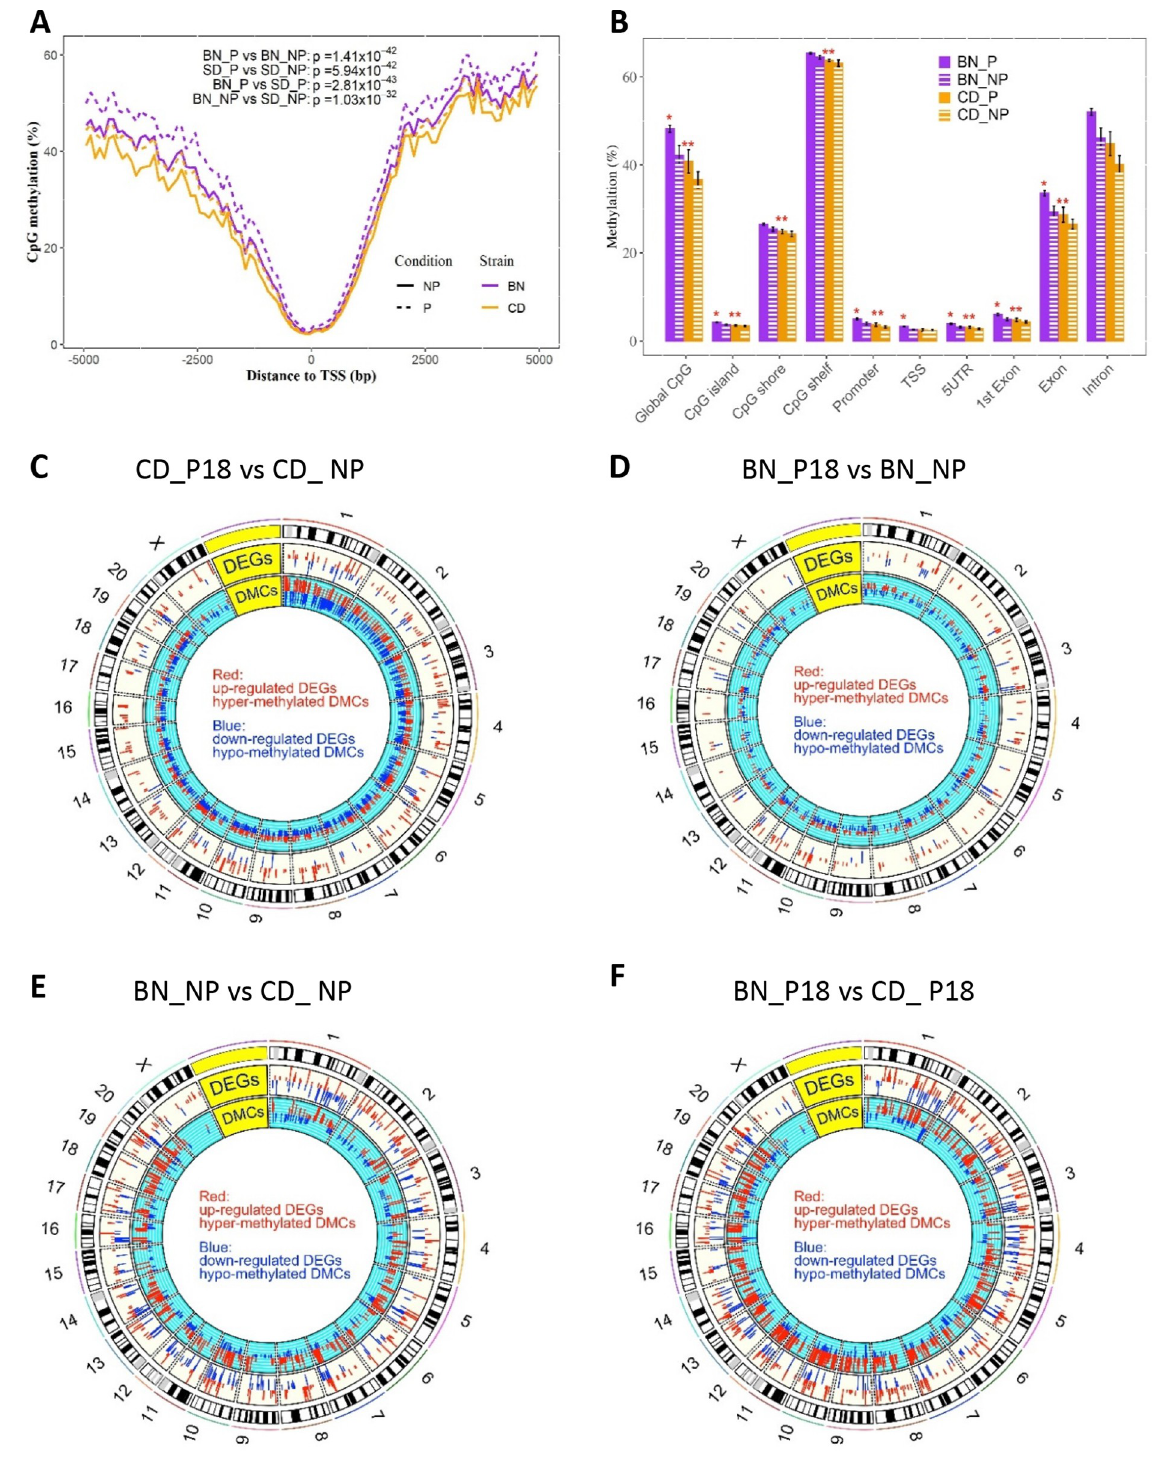
Fig 7. Genome-wide DMRs and integration with DEGs. A) CpG methylation levels in relation to TSS, B) Average CpG methylation levels according to genomic features. Integration of renal DMRs and DEGs is shown in circus plots of: C) pregnant CD compared to non-pregnant CD, D) pregnant BN versus non-pregnant BN, E) non-pregnant BN compared to non-pregnant CD, and F) pregnant BN versus pregnant CD. Lines/bars represent the average ± error (n = 3/group, 12 total). Paired t-test and two-tailed t-test was used to determine the significance in (A) and (B), respectively. � p < 0.05 BN_P vs BN_NP, �� p < 0.05 BN_P vs CD_P.